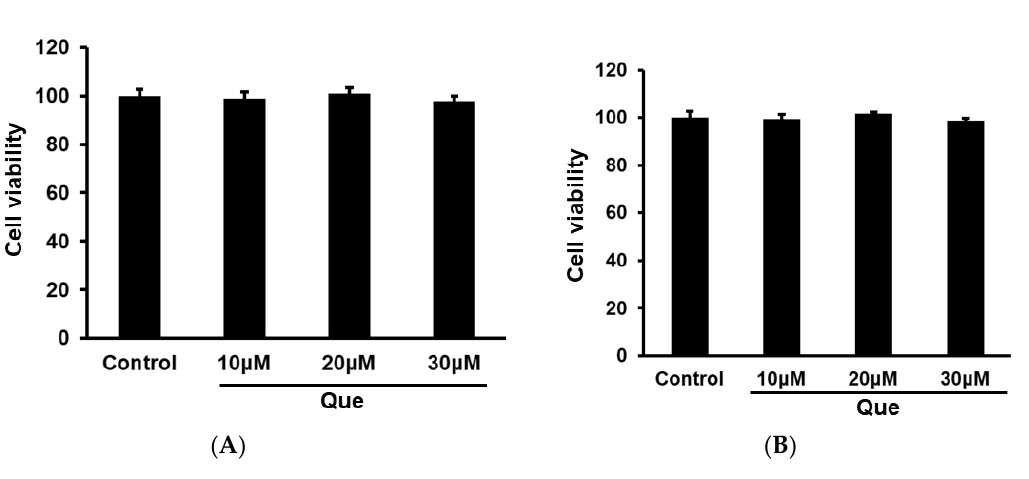
Figure 1. Quercetin did not exert cytotoxicity on RAW264.7 and peritoneal macrophages cells. RAW264.7 ( A ) and peritoneal macrophages cells ( B ) were incubated with Quercetin (10, 20 and 30 µ M) for 24 h. The cell viability was examined by CCK8 assay.